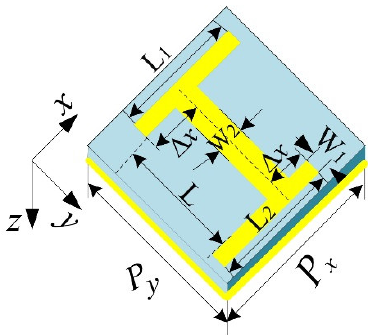
Figure 1. Schematic structure of an asymmetric H-shaped unit cell of the metamaterial. The geometric parameters of the unit cell are: ∆ x = 9 µ m, L = 28 µ m, L 1 = L 2 = 27 µ m, W 1 = 4 µ m, W 2 = 5 µ m, P x = P y = 40 µ m.